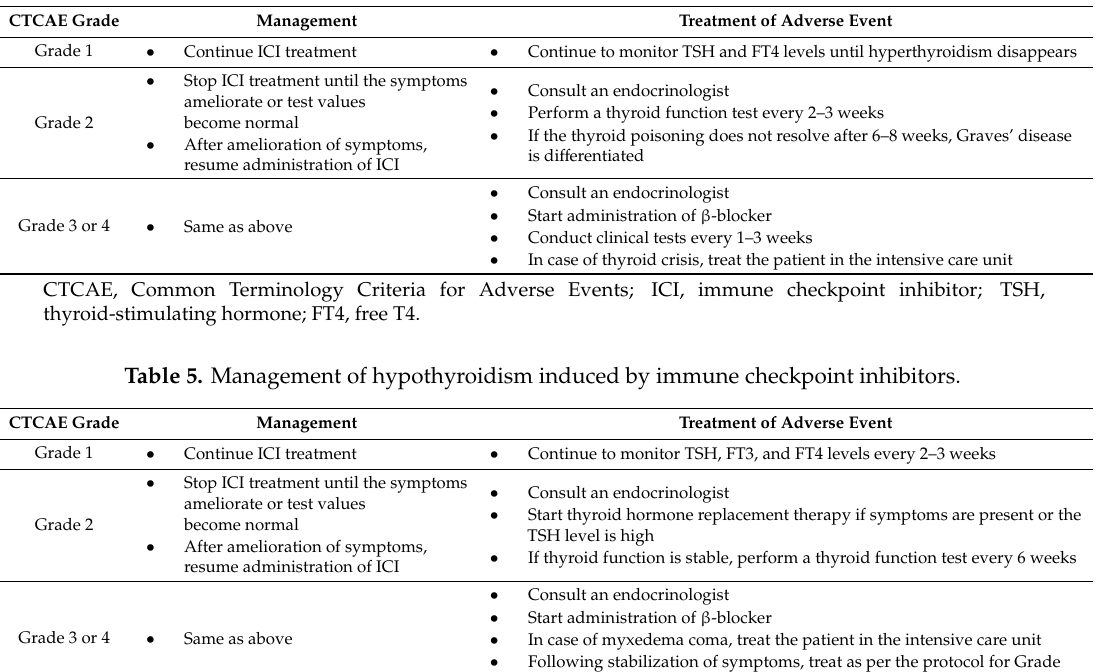
Table 4. Management of hyperthyroidism induced by immune checkpoint inhibitors.